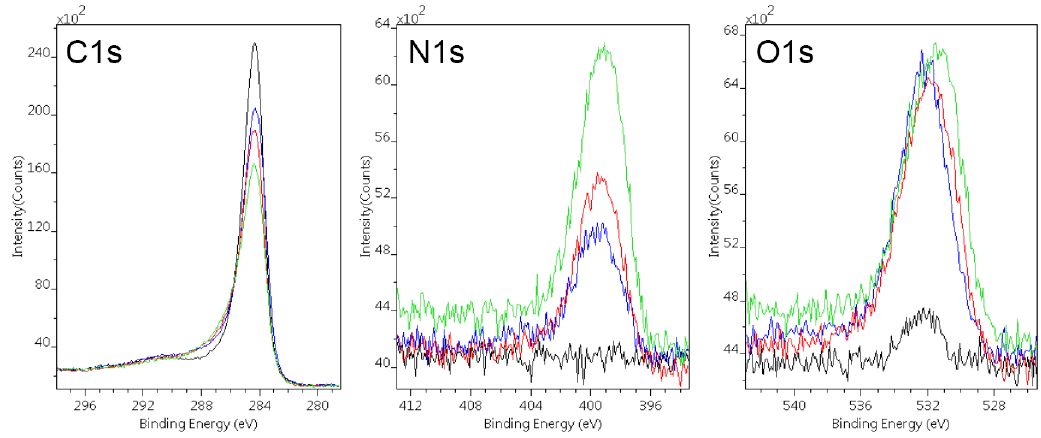
Figure 3: C1s, N1s and O1s lines of the HOPG samples treated at different bias (untreated black, 50 V blue, 100 V red, 200 V green) (colour online) .